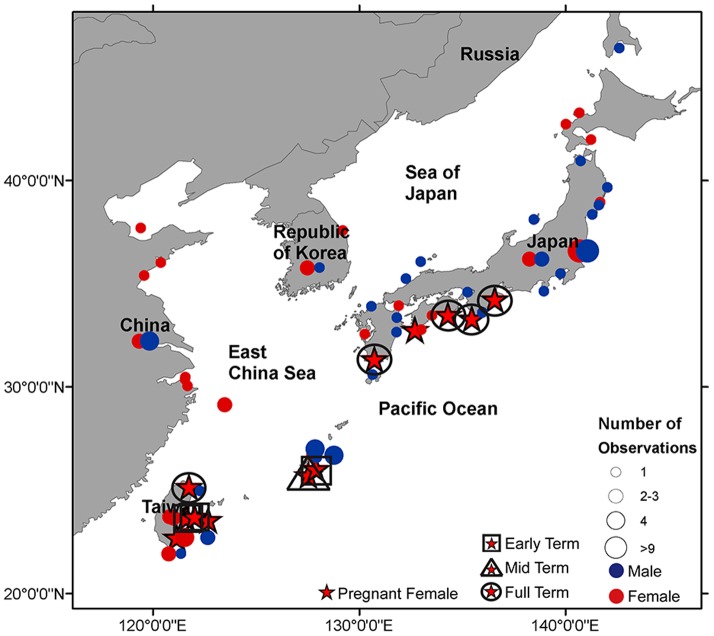
Location of white shark observations by sex.The occurrence of male, female and pregnant female white sharks in the Northwest Pacific. Circles on land underneath country label indicate observations that did not report a specific landing location. For pregnant females, black squares indicate early term, black triangles indicate mid term and black circles indicate full term for individuals where embryo size was reported.